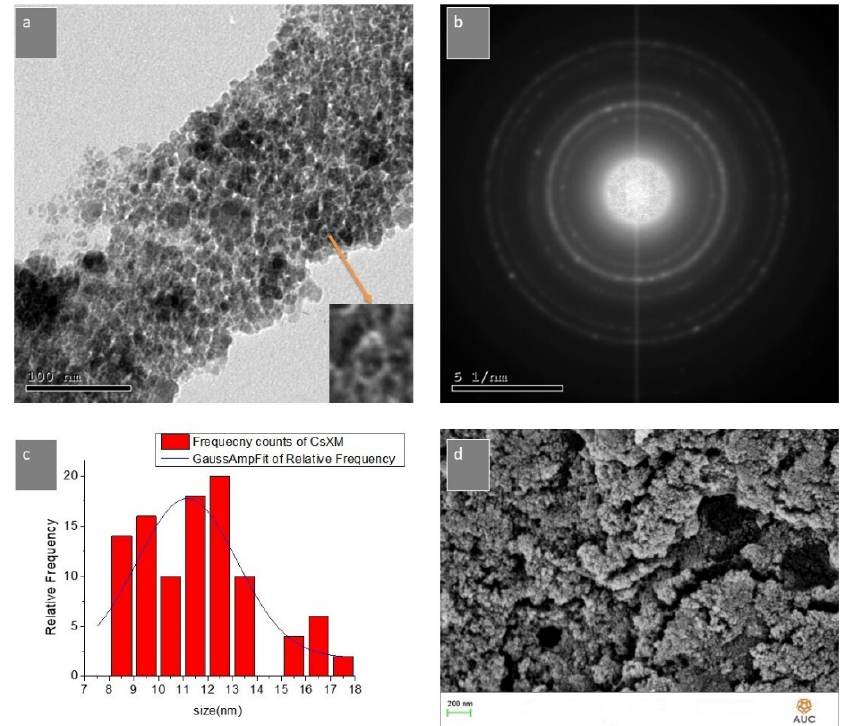
Figure 2. ( a ) TEM image, ( b ) Diffraction pattern, ( c ) particle size distribution histogram, and ( d ) SEM of CsXM nanoparticles.